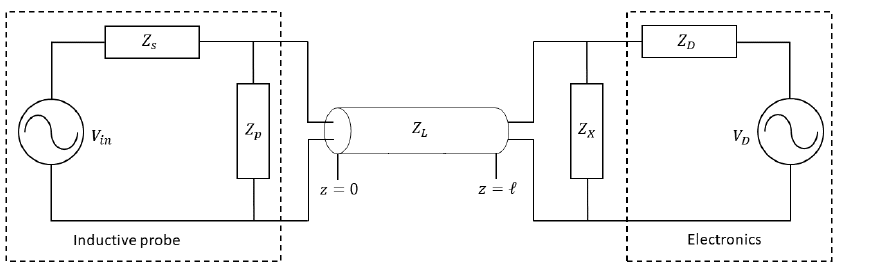
Figure 5. Model of the transmission line along with the magnetic probe and matching